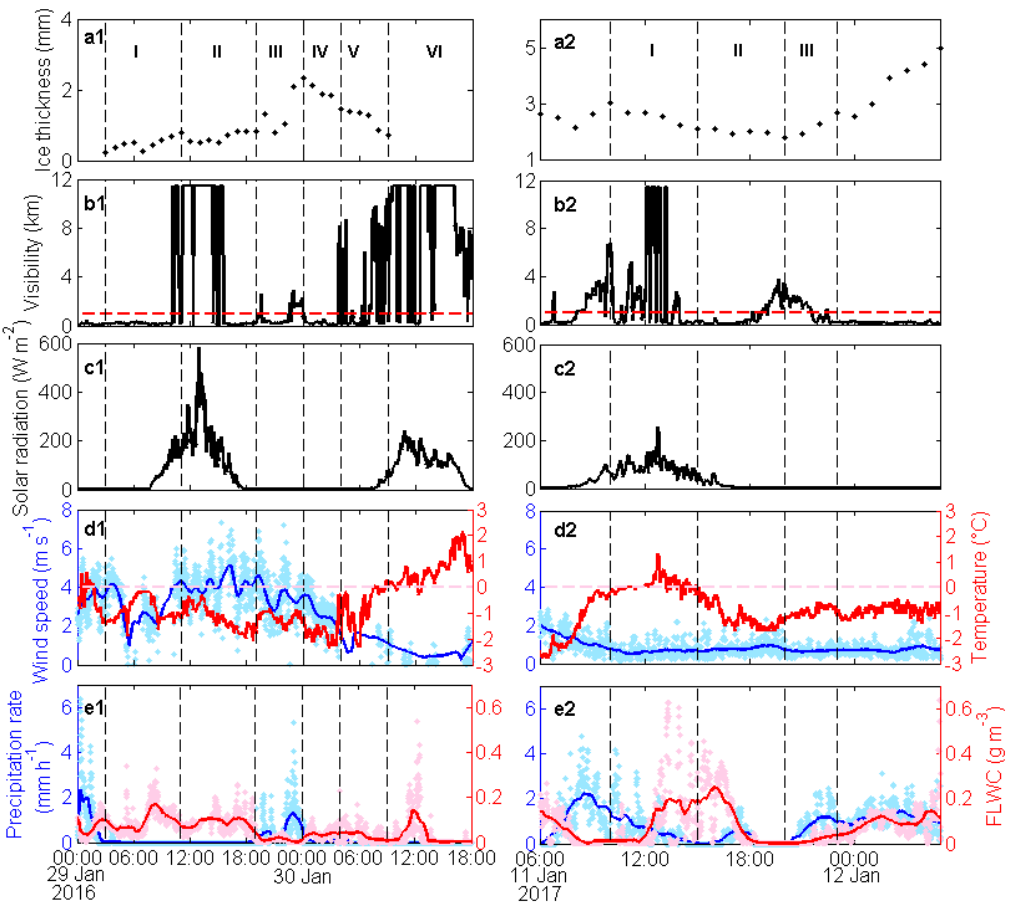
Figure 7. Temporal variations in ( a1, a2 ) ice thickness, ( b1, b2 ) visibility, ( c1, c2 ) solar radiation, ( d1, d2 ) wind speed (blue) and air temperature (red), and ( e1, e2 ) precipitation rate (blue) and fog liquid water content (FLWC) (red) during impermanent ice shedding periods of case 2 (left column) and case 4 (right column). Table 3. Icing growth / shedding rate, visibility, wind speed, air temperature, precipitation rate, and fog liquid water content (FLWC) in each phase of the impermanent ice shedding periods of case 2 and case 4.